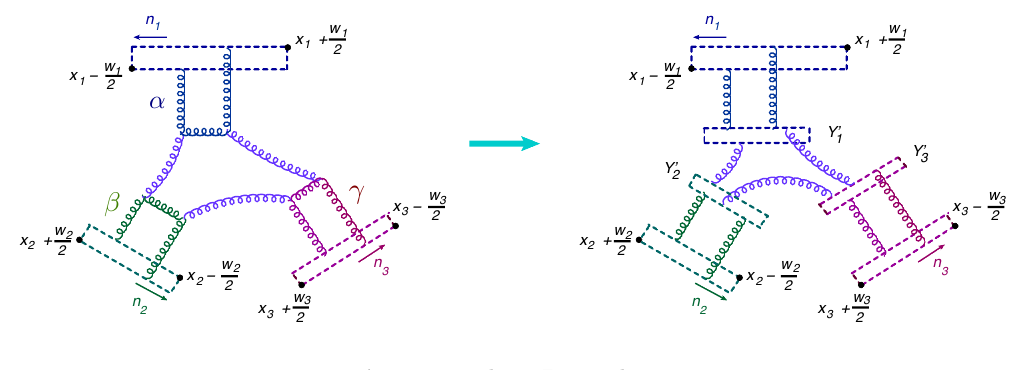
Figure 9 . Three BFKL